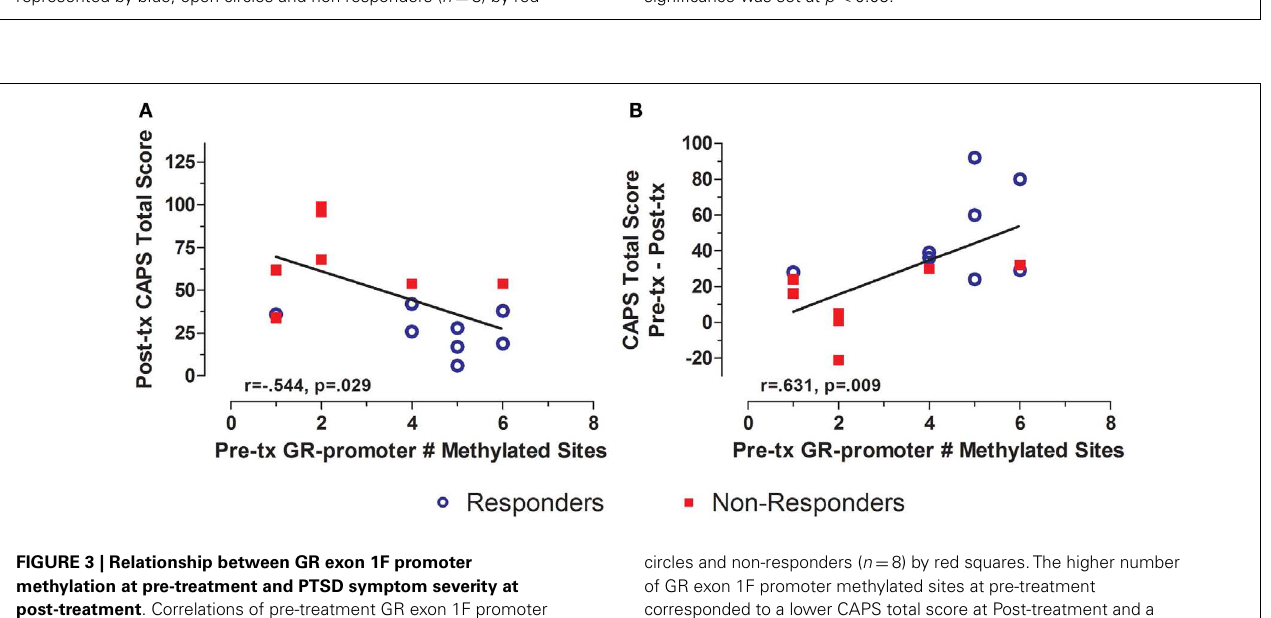
FIGURE 2 | GR- and FKBP5-promoter methylation at pre-treatment, post-treatment and follow-up . GR- (A,B) and FKBP5-promoter (C,D) methylation shown by mean ± SE of number of methylated sites (A,C) or sum % methylation (B,D) . Responders ( n = 8) to treatment are represented by blue, open circles and non-responders ( n = 8) by red